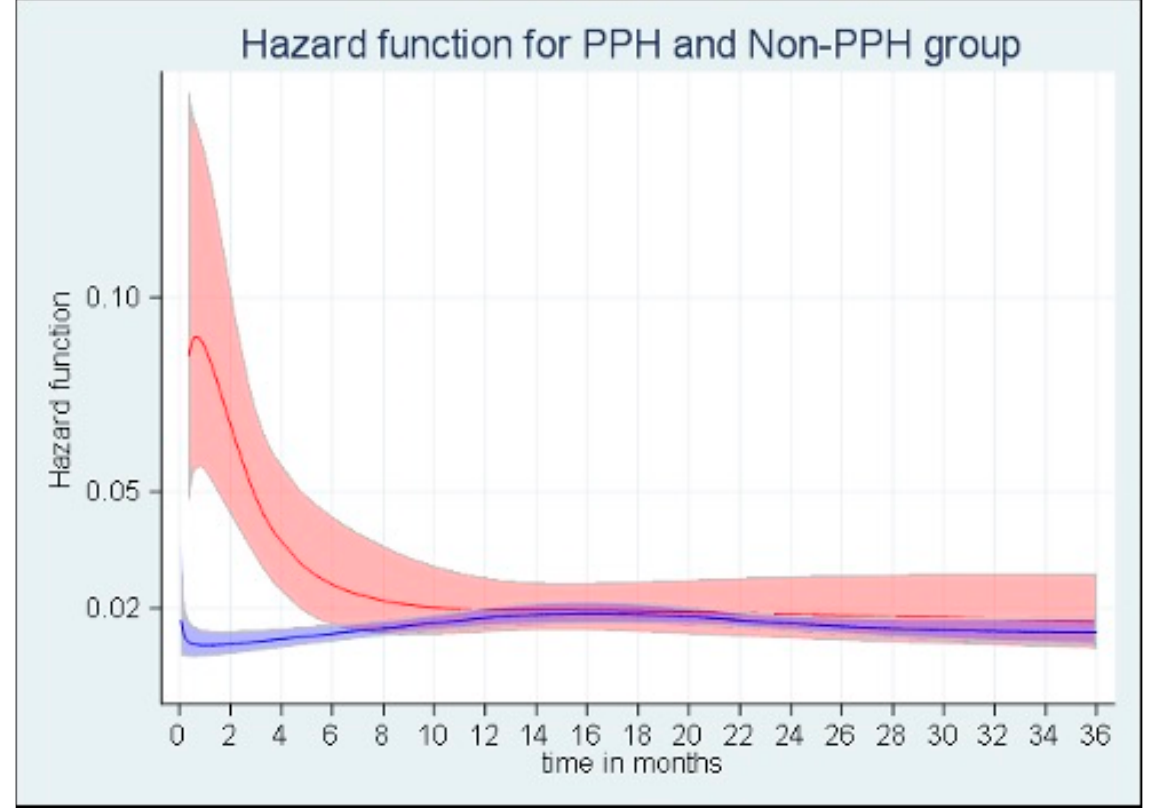
Figure 1. The functions of mortality risk over time in the PPH (red, n = 101) and non-PPH (blue, n = 729) groups in the flexible parametric survival analysis.